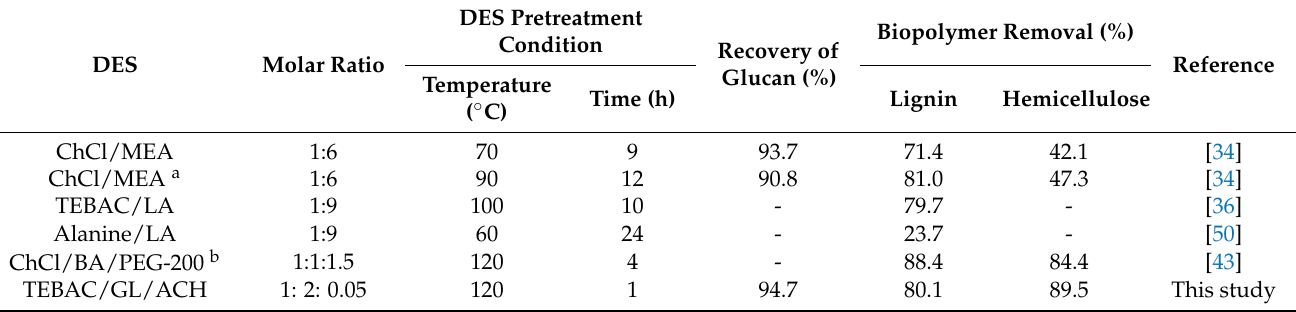
Table 3. The pretreatment effects of different DESs and pretreatment conditions on